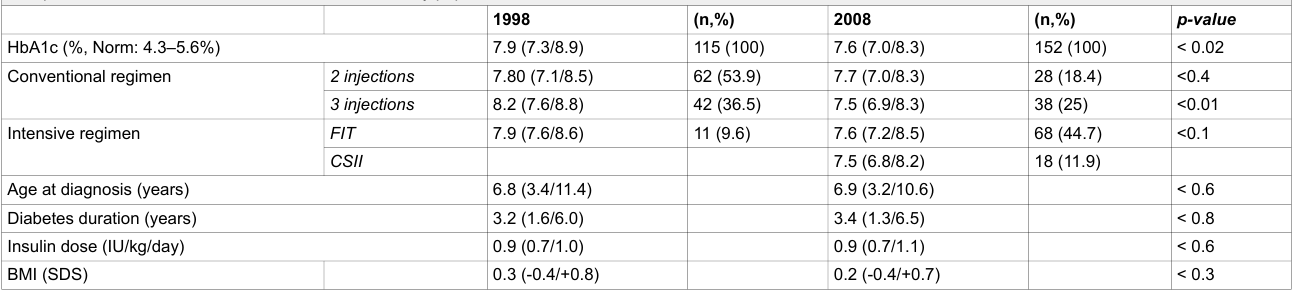
Table 2 Comparative statistics between the 1998 and 2008 study population. HbA1c (%, Norm: